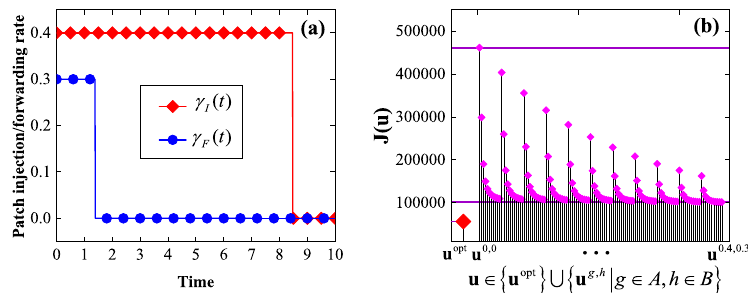
Figure 7. The experimental results in Example 2: ( a ) an optimal control, ( b ) a comparison between the optimal control and the set of static controls in terms of the energy efficiency.